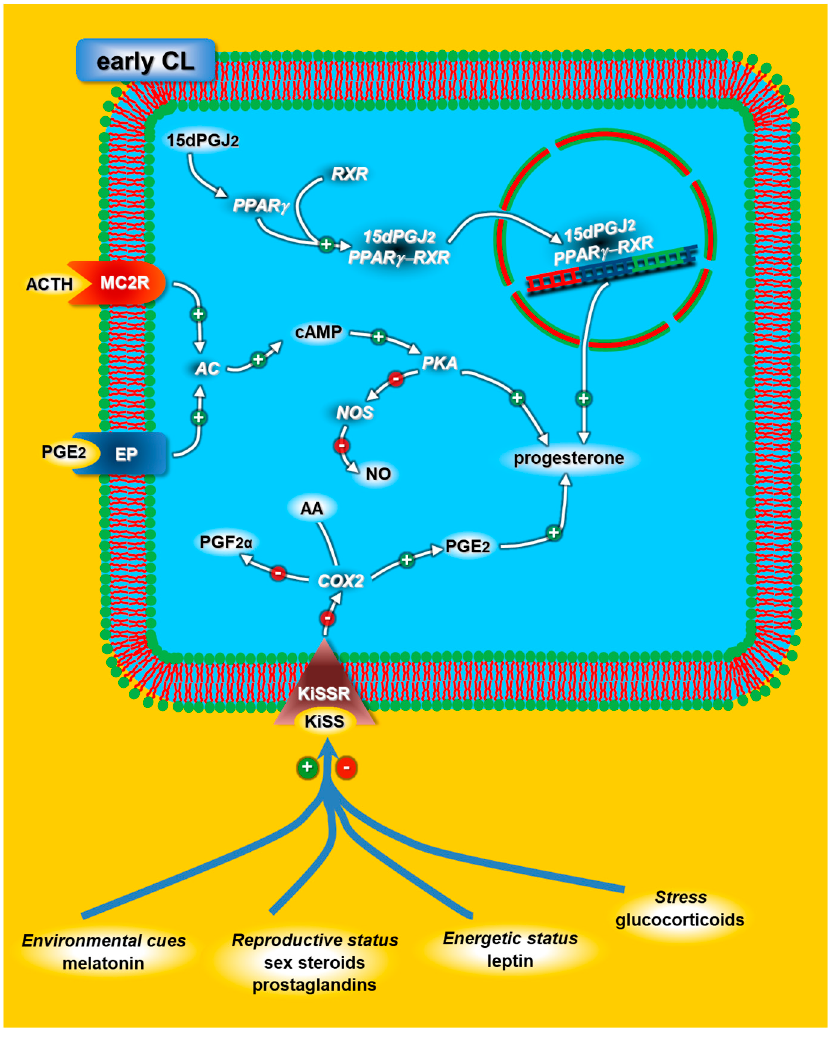
Figure 4. Schematic diagram of the adrenocorticotropic hormone (ACTH), kisspeptins (KiSS) and peroxisome proliferator-activated receptor (PPAR) mechanisms modulating progesterone release in early rabbit CL. The effectors that could directly modulate the KiSS/KiSSR (receptor) system at the CL level are represented by blue lines. For acronyms, see the list of abbreviations in the